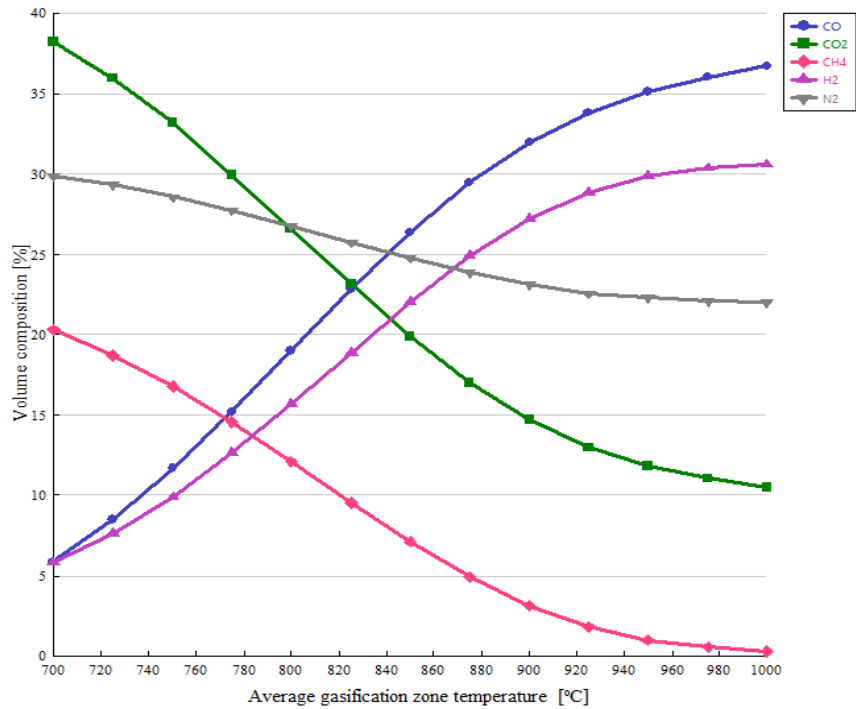
Figure 10. Syngas composition as a function of the gasification temperature when using enriched air (O 2 = 40%).